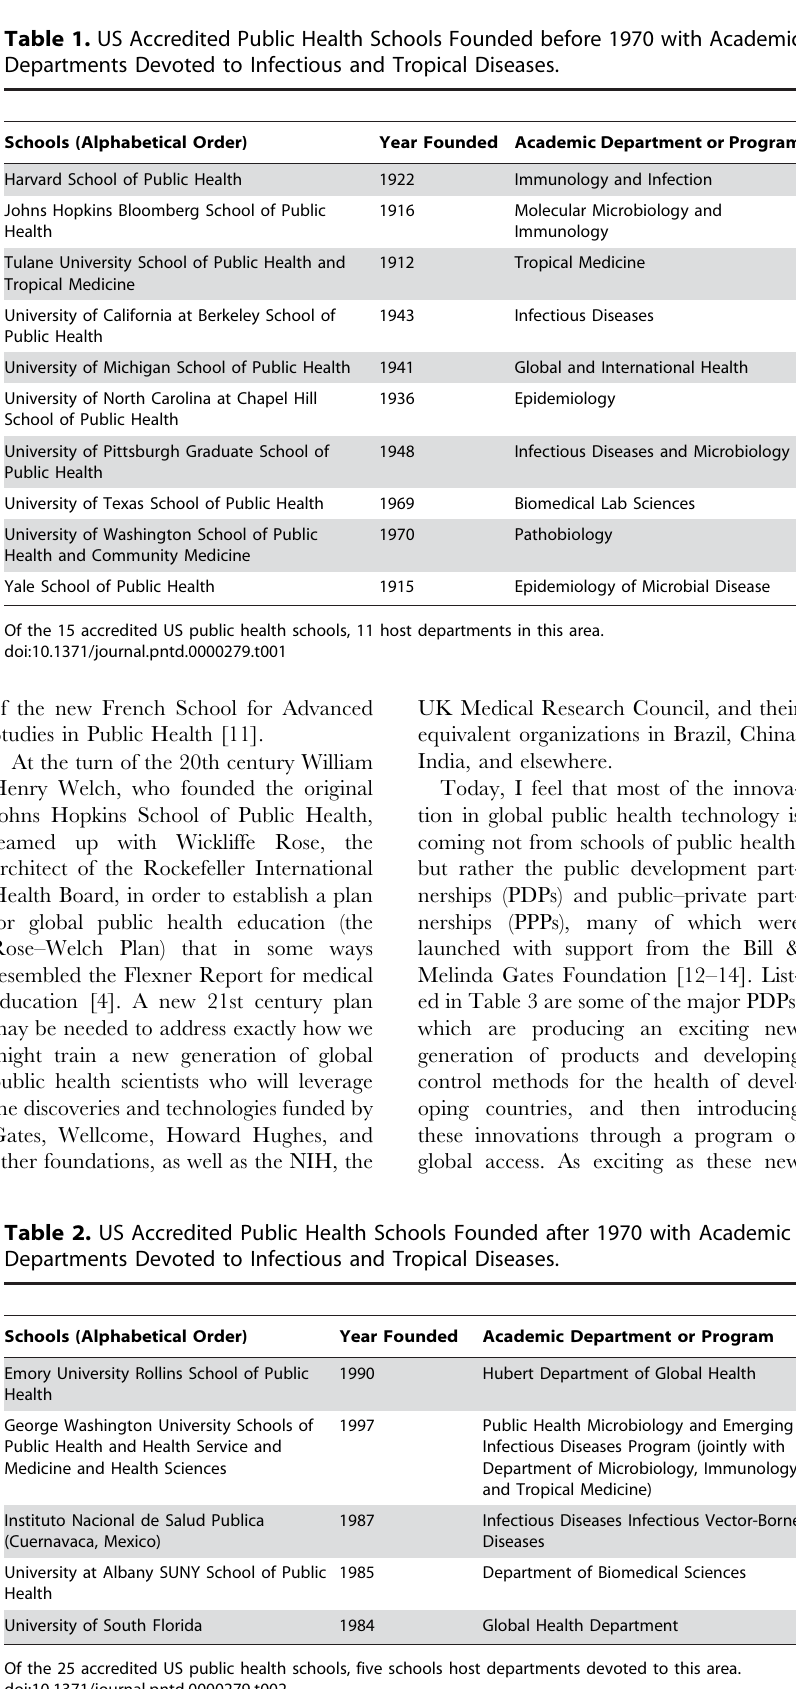
Schools (Alphabetical